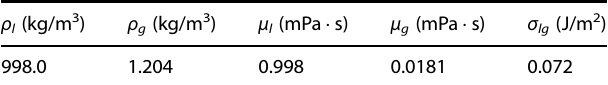
Table 4. Non-dimensional characterization for simulations, as de fi